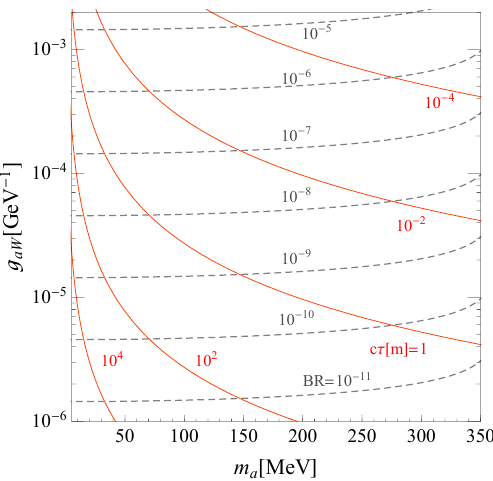
Figure 8 . Branching ratio of K L ! (cid:25) 0 a (in gray, dashed) and proper lifetime of the ALP in meters (in red) of the SU(2) coupled ALP. The branching ratio of K + ! (cid:25) + a is not shown in the